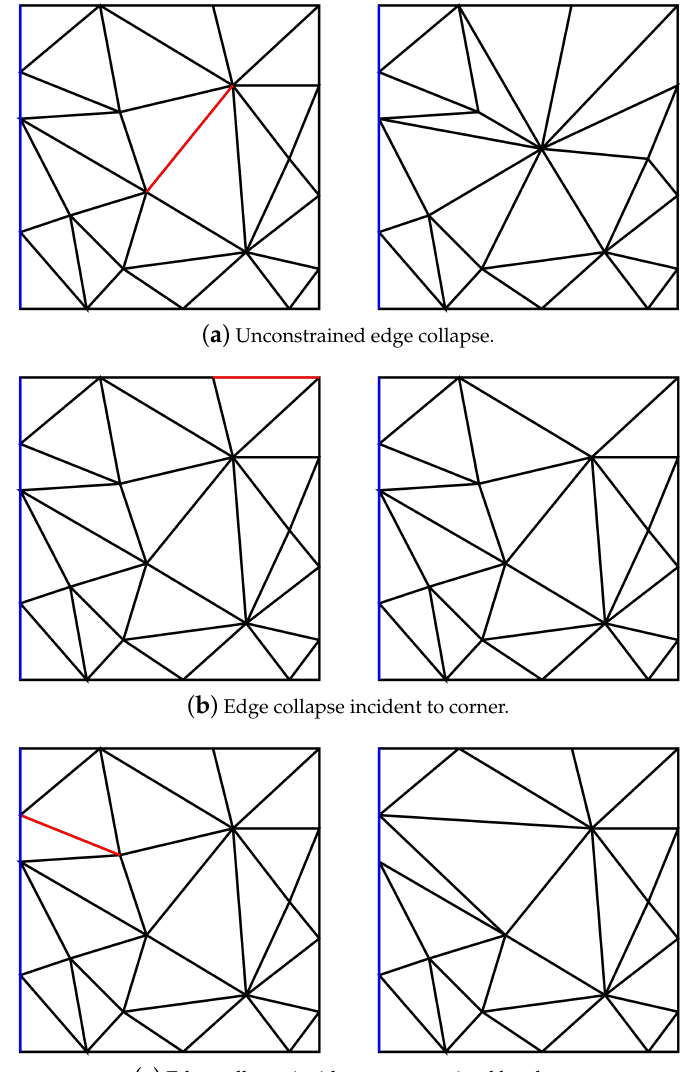
Figure 4. The edge collapse cases. In this figure, we mark in blue the edges on a constrained border, and in red the edge to collapse. The left column shows the 2D projection of the mesh before collapsing and the right column, the result after collapsing. In ( a ), the edge to collapse is not incident to a corner nor to a constrained border edge, so the collapse occurs following the vertex placement rules in [14]. On the contrary, in ( b ) the edge is incident to a corner vertex, and we force the candidate simplification point to be that corner in order to preserve the square shape of the tile. Finally, in ( c ) one of the vertices of the edge to collapse is incident to the constrained border, so the vertex placement forces the vertex resulting from the collapse to be the vertex on the border. Note that, in this figure, we omit the case in which the candidate edge to simplify is on the constrained (blue) border, as in this case the collapse is not